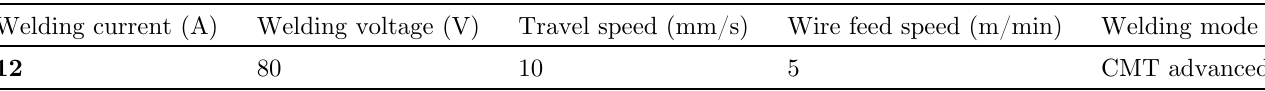
Table 3. Test-case parts welding